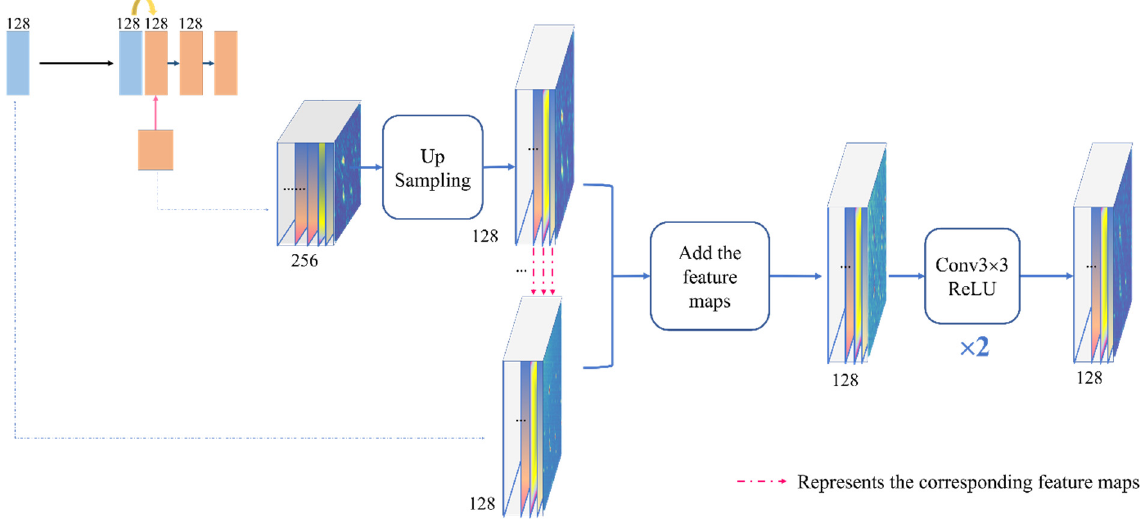
Figure 6. Schematic diagram of the up-sampling and skip connection process.